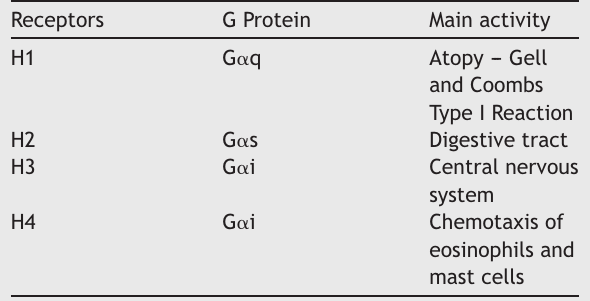
Antihistamines and histamine receptors. G